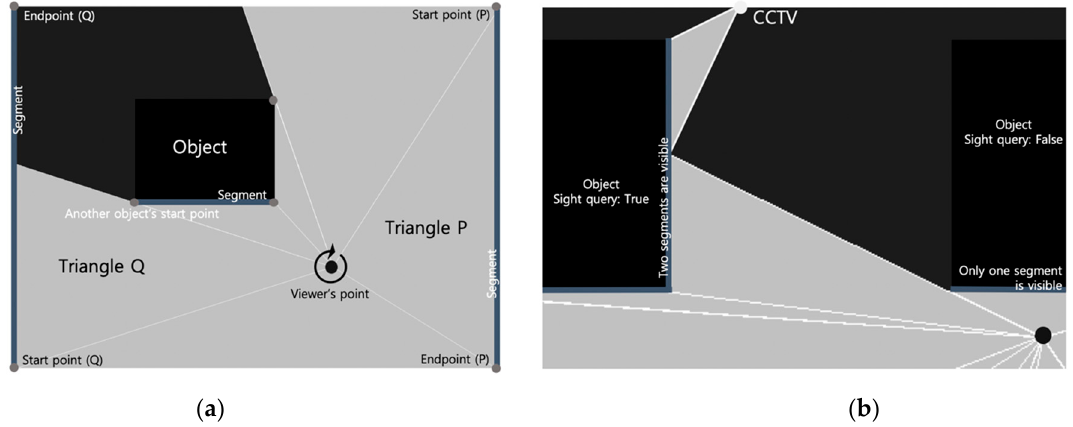
Figure 8. Checking visibility constraints: raycasting approach ( a ) and sight query algorithm ( b ).